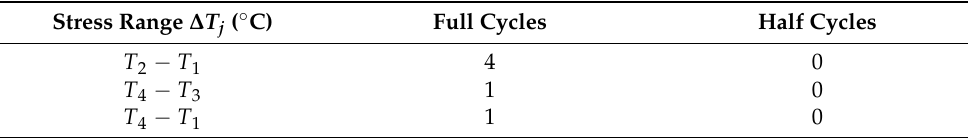
Table 8. Half-cycle matching and rainflow-counting